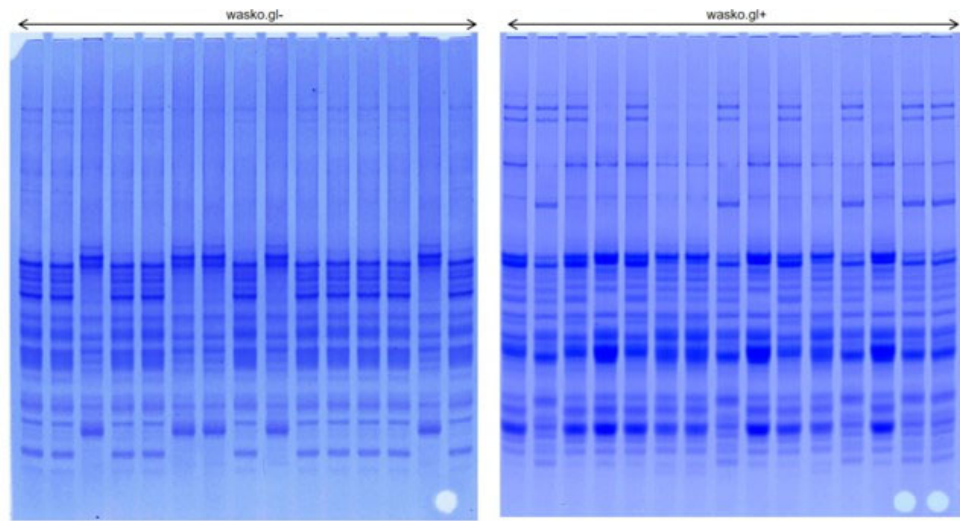
Figure 1. Genotype without (V1—wasko.gl − ) and with (V2—wasko.pg+) ω —gliadin [9].